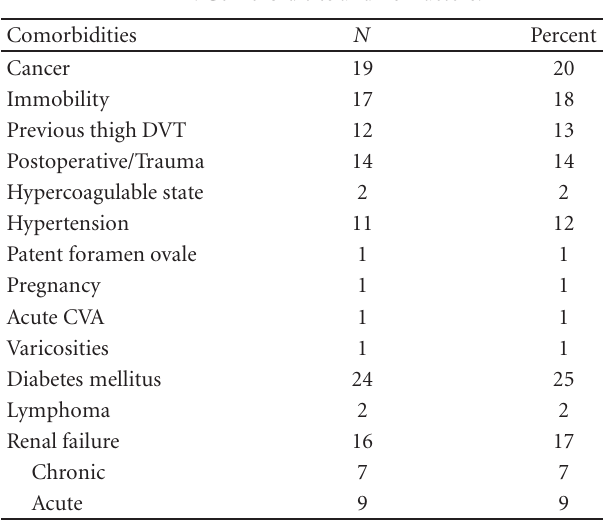
Table 2: Comorbidities and risk factors.